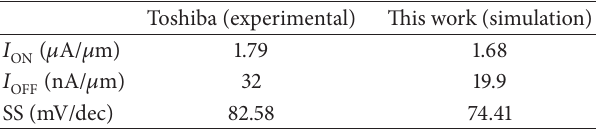
Figure 13: Subthreshold slope as a function of supply voltage. Table 3: Comparison of performance parameters under subthresh- old